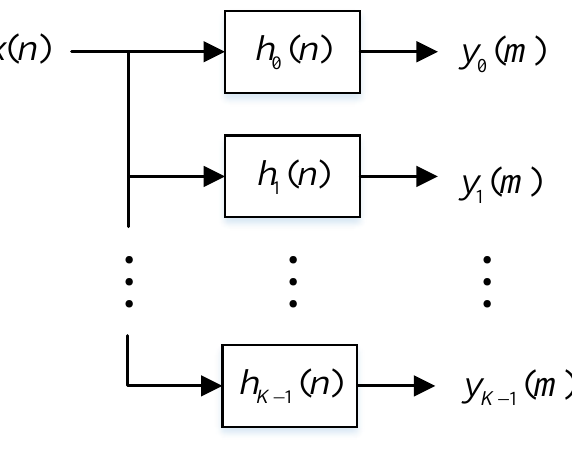
Figure 1. The filter banks for channelization.